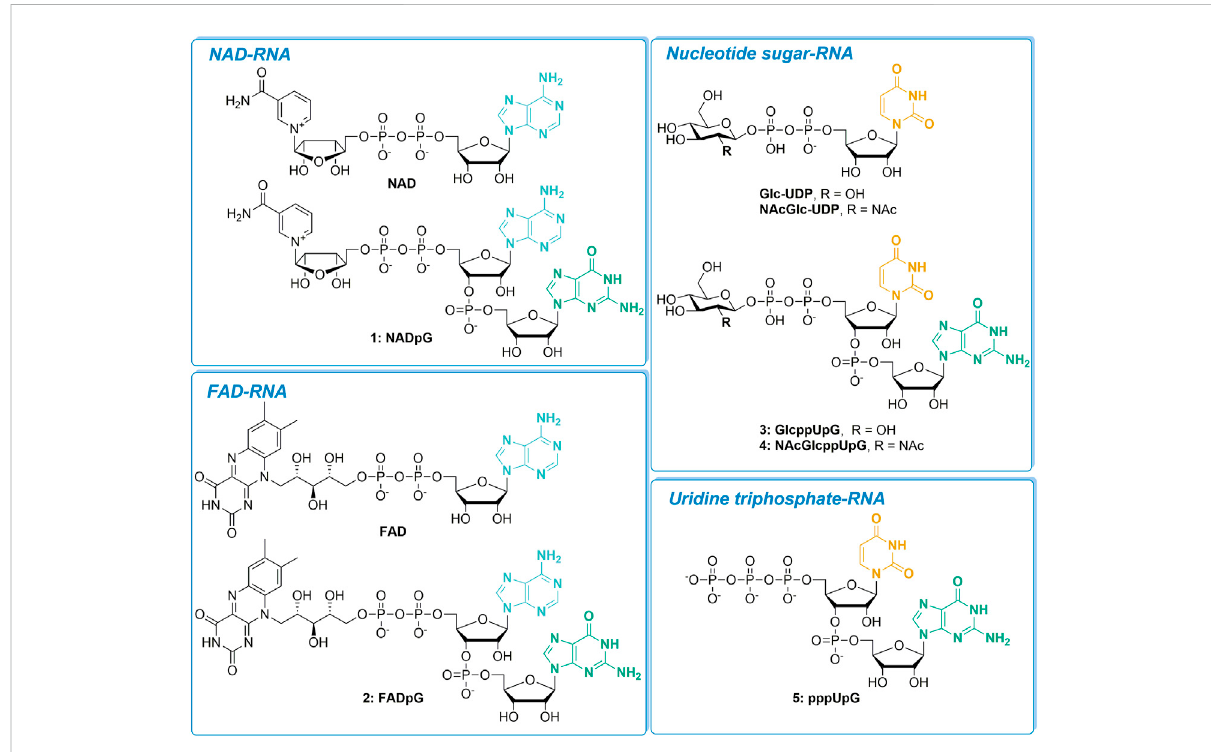
FIGURE 1 The set of nucleotide derivatives used for in vitro transcription studies, divided into four categories according to the type of RNA 5 ′ -end they produce.